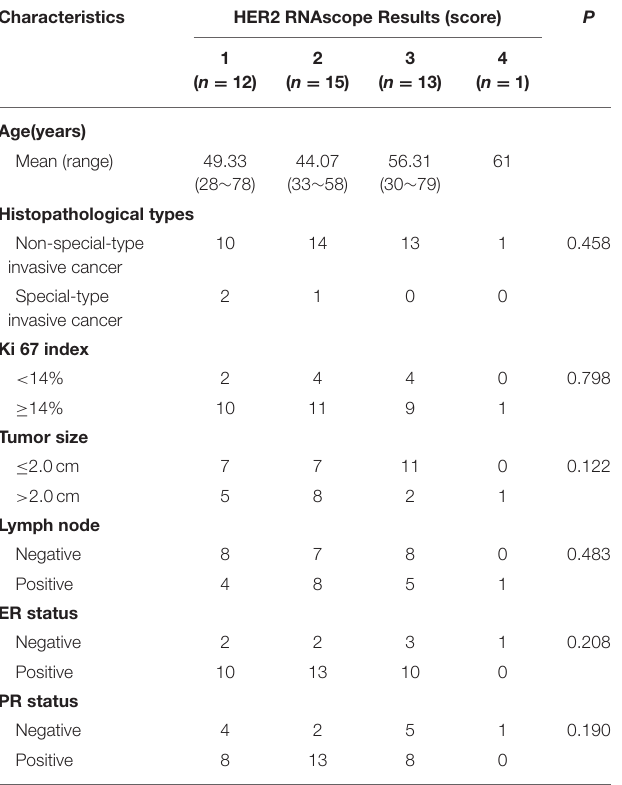
TABLE 1 | Comparison of HER2 mRNA expression and clinicopathological characteristics of breast cancers with IHC2 + and FISH group 2 in the study cohort.